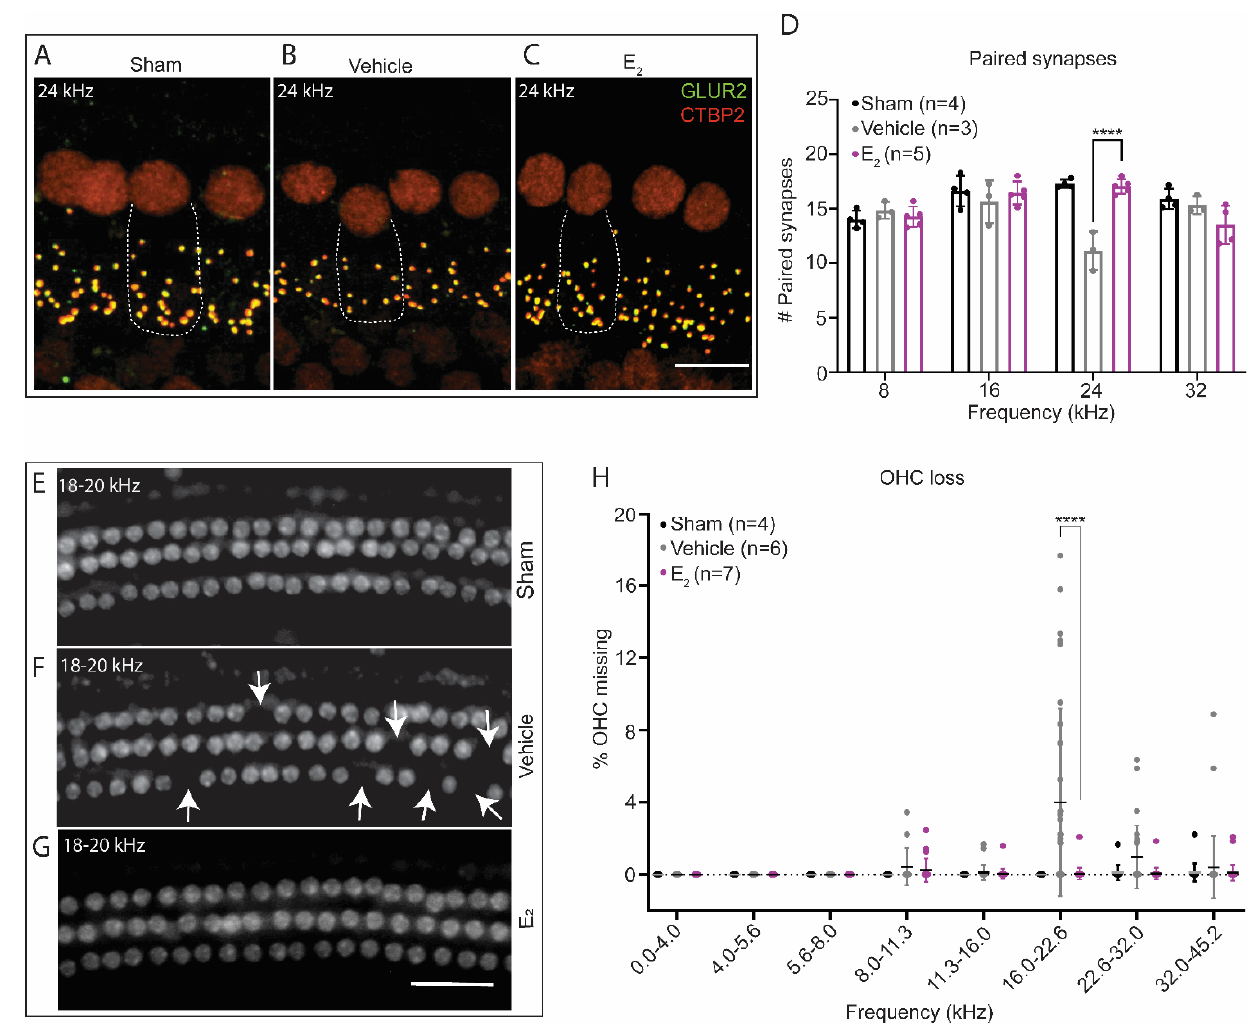
Figure 7. E 2 -replacement in gonadectomized female mice ameliorates cochlear synaptopathy and OHC loss following a TTS-inducing noise exposure. ( A – C ) Representative images of paired IHC-ANF synapses at 24 kHz 1-week post-exposure in ( A ) sham-exposed mice, ( B ) vehicle-treated mice, and ( C ) E 2 -treated mice. Paired synapses were identified via the co-localization of CTBP2 (red) and GLUR2 (green). Sham animals were gonadectomized and vehicle-treated but not noise-exposed. ( D ) E 2 -replacement (150 µg/kg) ameliorates cochlear synaptopathy at 24 kHz 1-week following a TTS-inducing noise (94 dB SPL, 8–16 kHz, 2-h) ( p < 0.0001). Compared to a group of sham exposed mice, E 2 -treated mice display no loss of synapses at 24 kHz, while vehicle-treated mice display, on average, a loss off 5.9 synapses at this frequency. ( E – G ) Representative cytocochleograms 1-week post-exposure at the approximate cochlear location of 18–20 kHz in ( E ) sham-exposed mice, ( F ) vehicle-treated mice, and ( G ) E 2 -treated mice. White arrows indicate missing OHCs. ( H ) Vehicle-treated mice display increased susceptibility to OHC loss 1-week following a TTS-inducing noise exposure. Compared to E 2 -treated female mice, vehicle-treated female mice displayed significantly increased OHC loss restricted to the frequencies between 16.0 kHz and 22.6 kHz ( p < 0.0001). Neither group of animals displayed significant OHC loss below 16 kHz or above 22.6 kHz. Paired synapse counts and OHC loss were compared using a 2-way ANOVA followed by Sidak’s multiple comparison test. Dotted lines in ( A – C ) represent the outline of a single inner hair cell. n = number of ears, plots: mean ± SD; scale bar in ( C ): 10 µm; scale bar in ( G ): 50 µm; **** p < 0.0001.